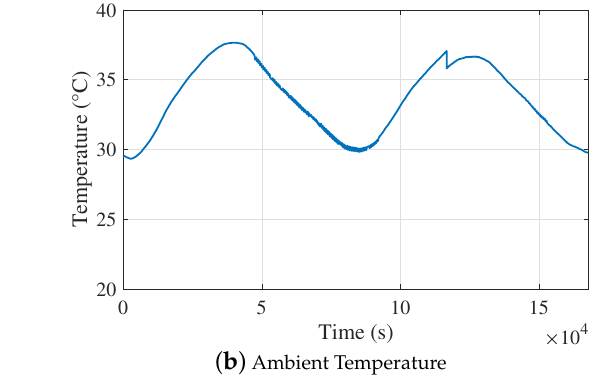
Figure 12. Two-day electricity and temperature profiles.